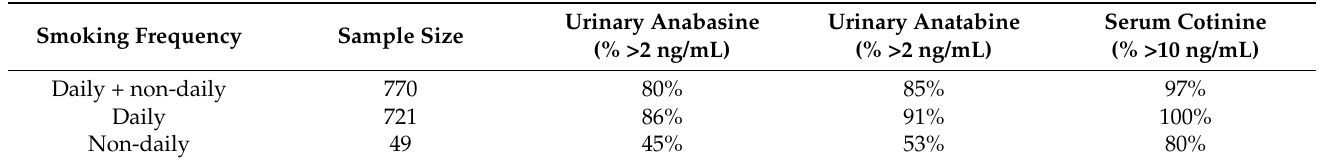
Table A1. Percent of participants correctly classified based on cut points of urinary anabasine (2